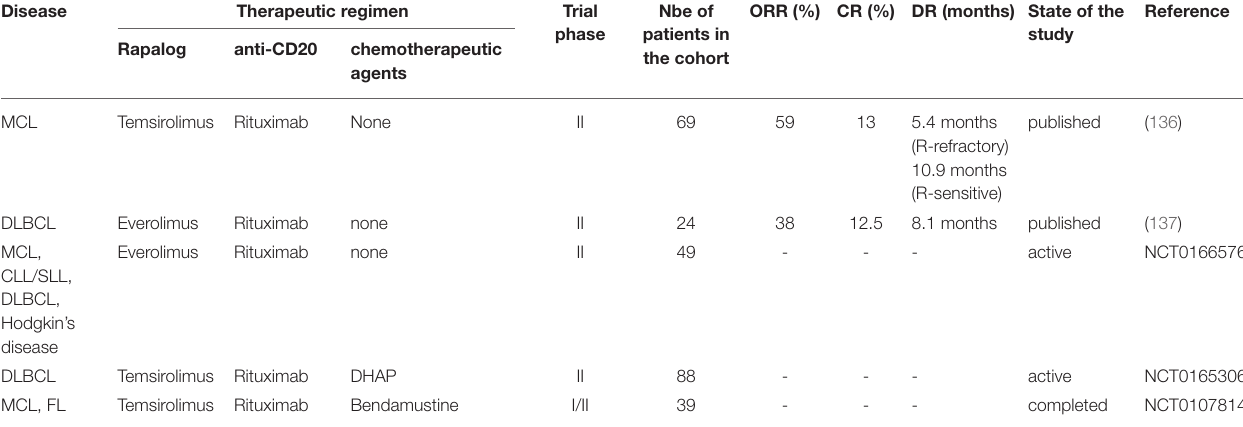
TABLE 2 | Phase I/II and phase II studies (ongoing or published) evaluating the effect of rapalogs in combination with anti-CD20 or anti-CD20-based therapies.